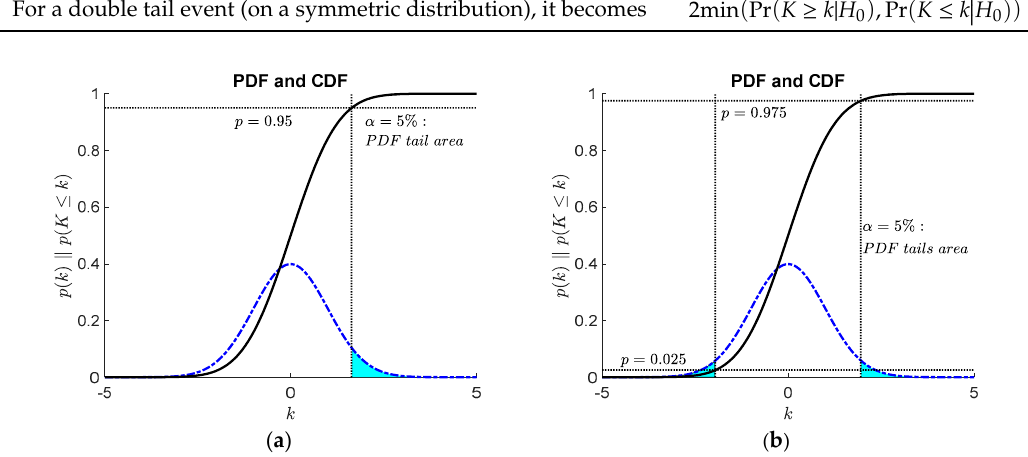
Figure 4. One or two tail hypothesis testing principle: significance 𝛼 (limit for the p -value) and critical value(s) of the confidence interval highlighted ( a ) single sided; ( b ) double sided. Table 6. Hypothesis testing: p -value logic. Confidence Interval